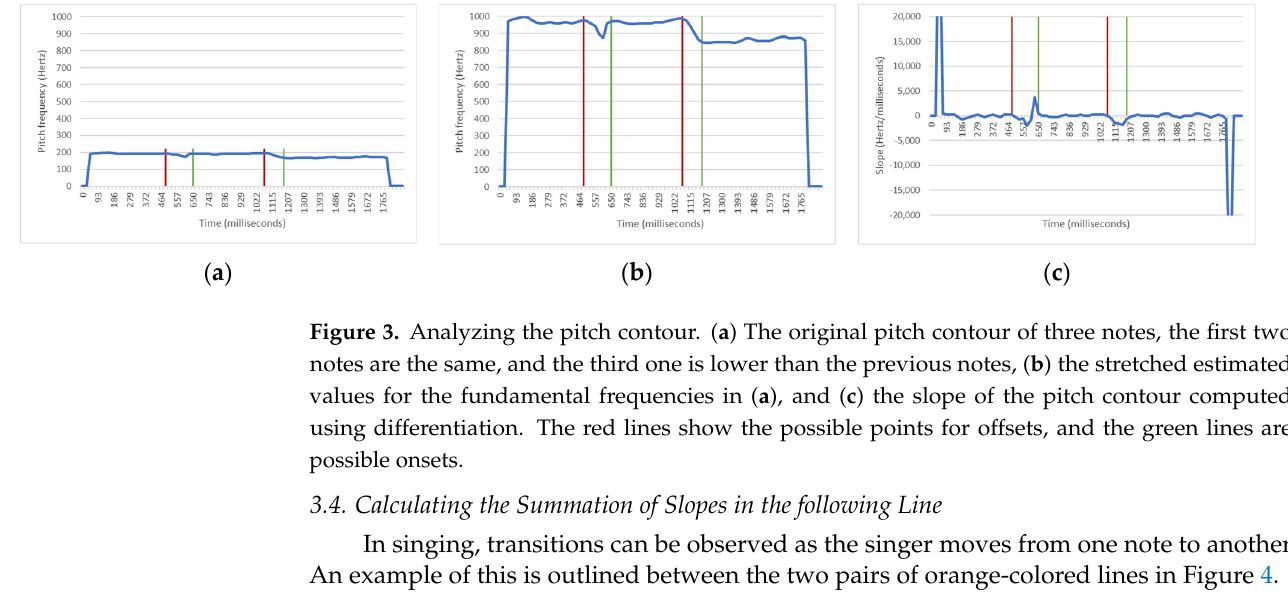
possible offset points, and the vertical green lines are the possible onset points.